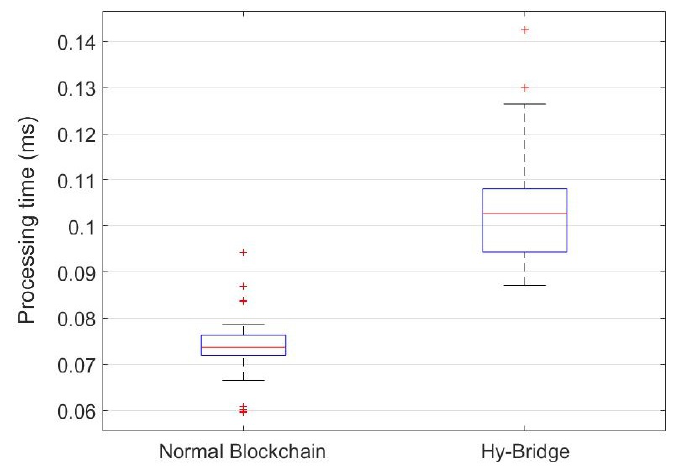
Figure 10. CPU percentage used by Hy-Bridge and the normal blockchain based on IoT power consumption presented in Table 1.